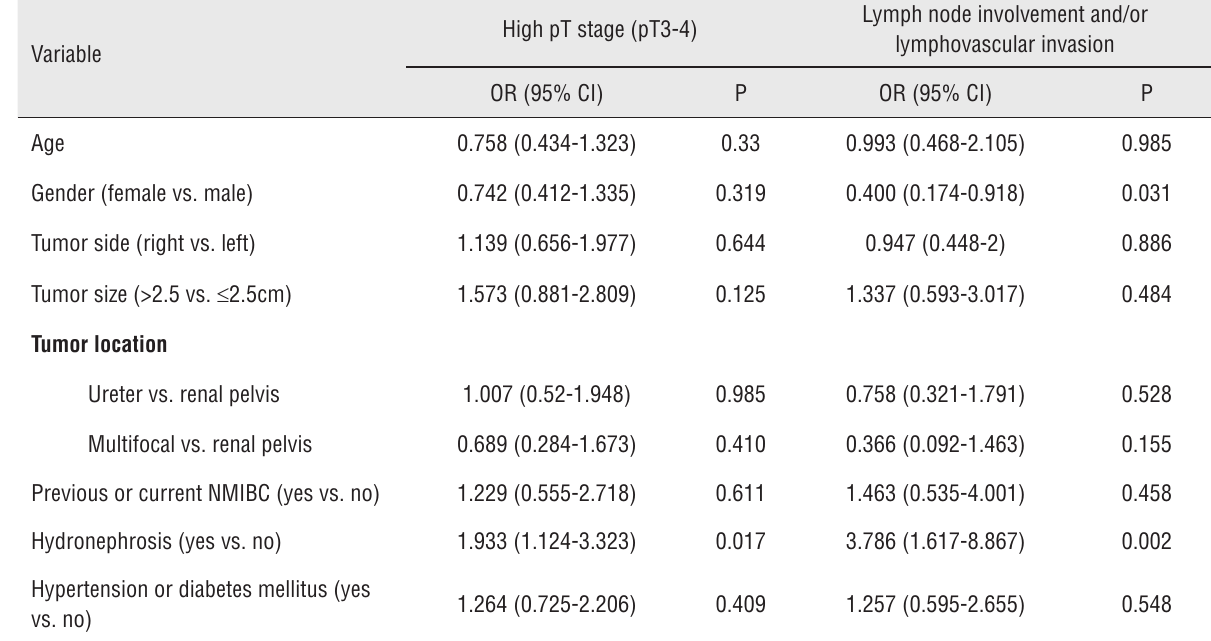
Table 3 - Multivariable logistic regression analysis for adverse pathologic features in patients with high-grade upper tract urothelial